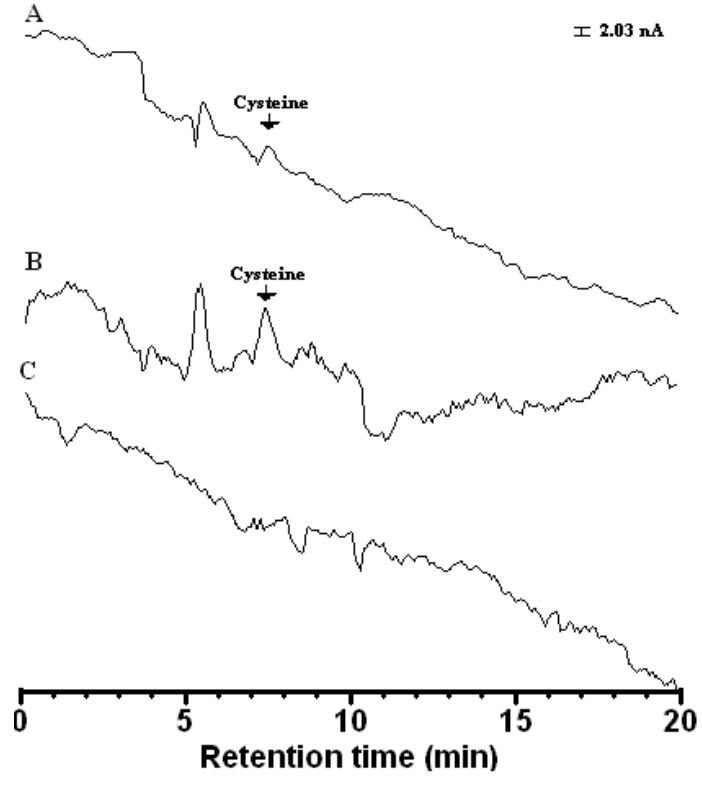
=180 ms, t = 180 1 2